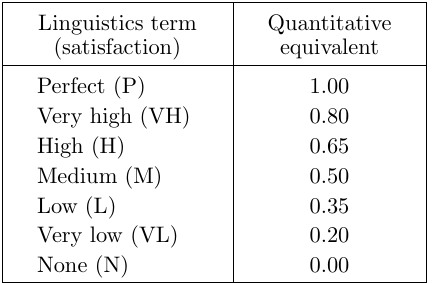
7-point linguistic